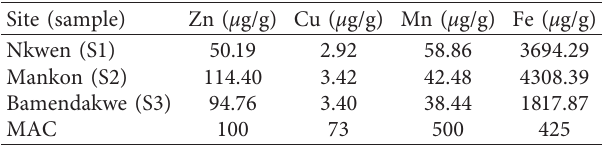
Table 4: Trace element content in